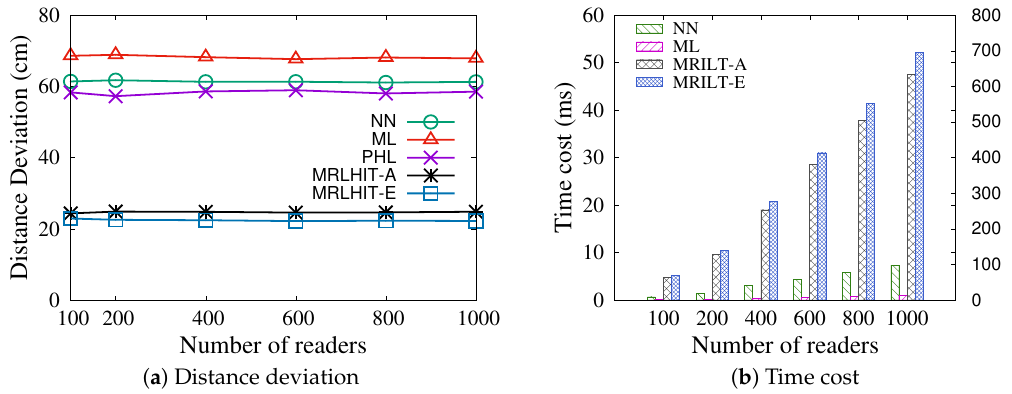
Figure 9. Varying the number of readers with δ d = 20 cm, δ s = 3, grid _ size = 60